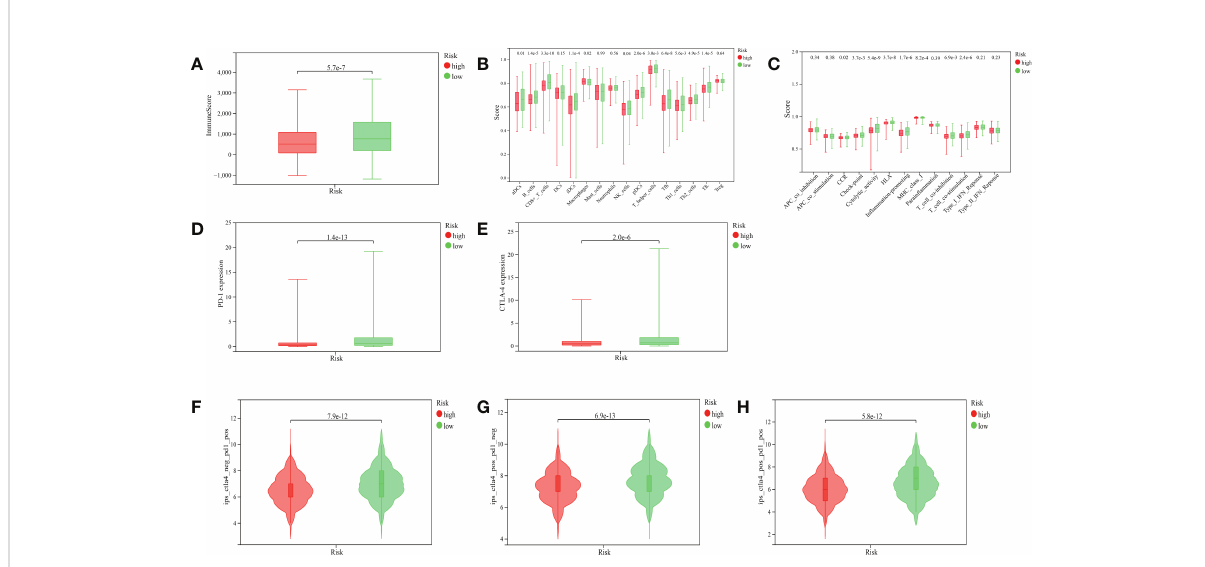
FIGURE 7 Correlation between the ARlncRNA model and tumor immunity. (A) A boxplot showing that patients in the low-risk group have a higher ImmuneScore. (B) A multi-boxplot revealing that several cells such as aDCs, B cells, CD8+ T cells, iDCs, NK cells, pDCs, T helper cells, Tfhs, Th1 cells, Th2 cells, and TILs were more active in the low-risk group, while macrophages were more active in the high-risk group. (C) A multi- boxplot revealing that several immune-related pathways such as CCR, checkpoint, cytolytic activity, HLA, in fl ammation promoting, MHC class I, T-cell co-inhibition, and T-cell co-stimulation were more active in the low-risk group. (D, E) Boxplots indicating that the expression levels of PD-1 (D) and CTLA-4 (E) were higher in the low-risk group. (F, G, H) Violin plots showing that regardless of whether it is anti-PD1 alone (F) , anti-CTLA4 alone (G) , or a combination of the two (H) , their ef fi cacy in patients in the low-risk group was better than that in the high-risk